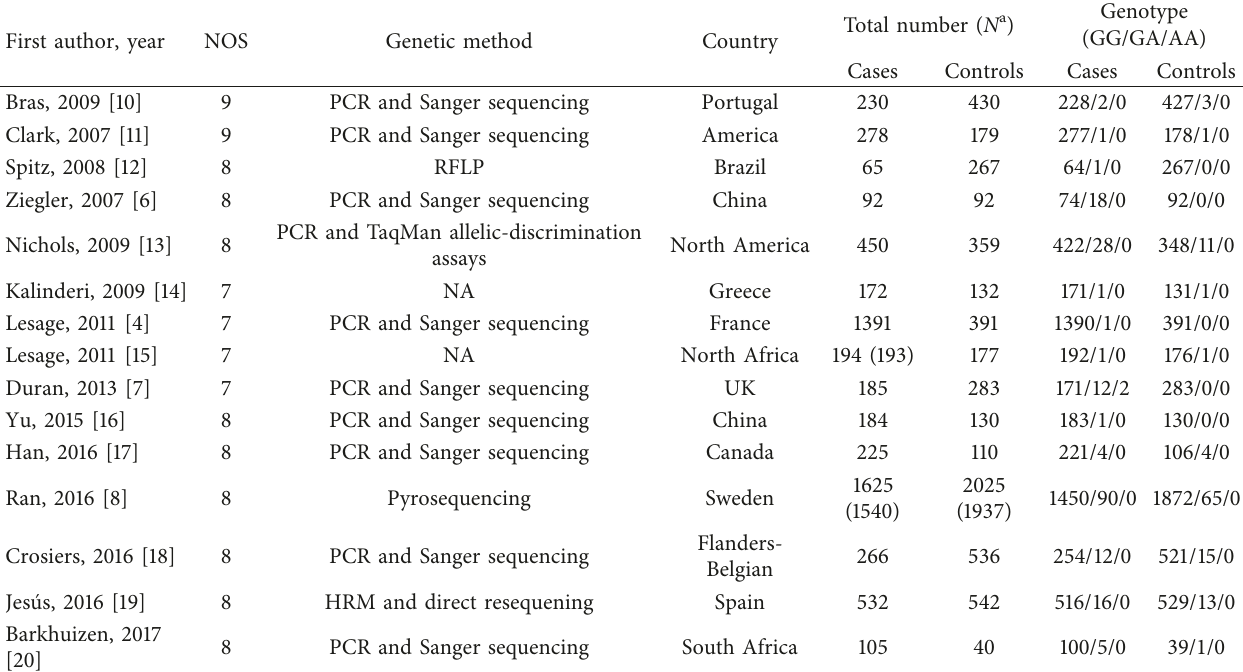
Figure 1: Flowchart of included publications. Table 1: The characteristics of all included